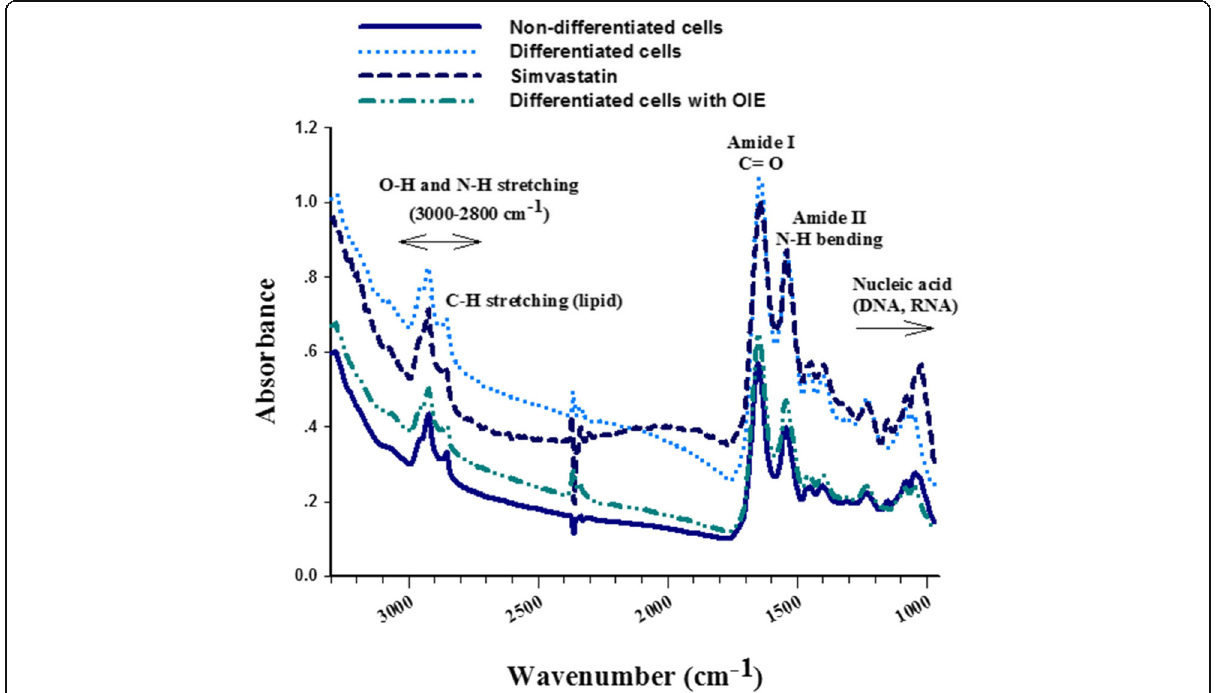
Fig. 5 Average original FTIR spectra (3000 – 950 cm − 1 ) obtained from 3T3-L1 cells. The raw spectra of non-differentiated cells (preadipopcytes) ( n = 62), differentiated cells ( n = 92), simvastatin and Oroxylum indicum extract treated 3T3-L1 adipocytes ( n = 47) after 10 days